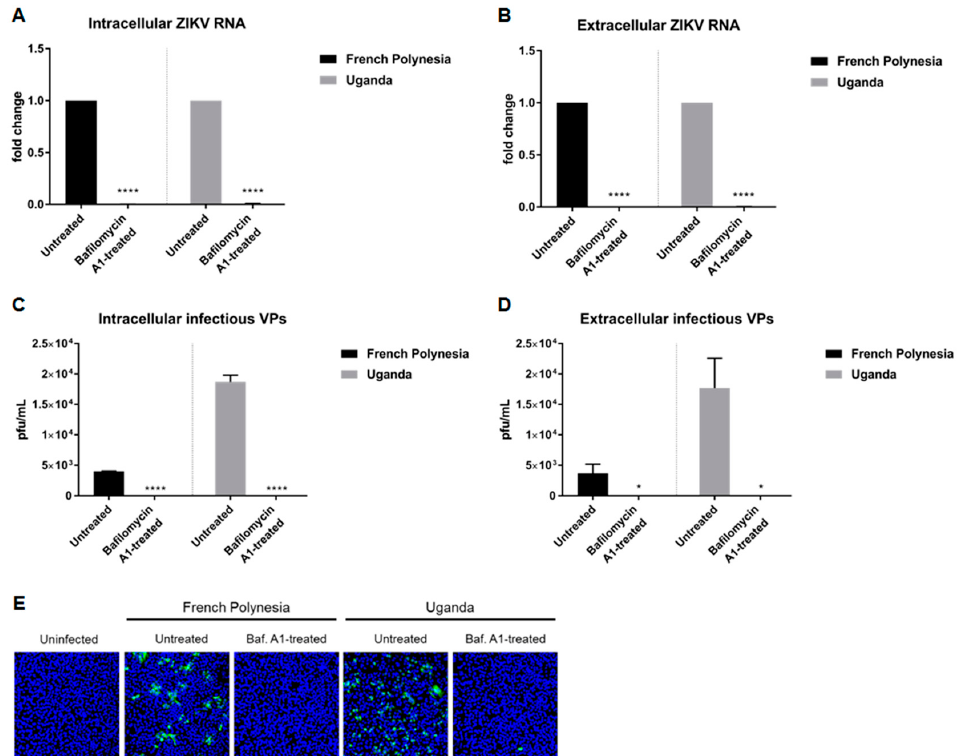
Figure 1. Bafilomycin A1 prevents the establishment of ZIKV infection in A549 cells ( A ) Quantification of the amount of intracellular ZIKV RNA of A549 cells infected with either the French Polynesia or the Uganda strain and treated with 10 nM bafilomycin A1 (pre-infection treatment). Quantification was performed by RT-qPCR and the amount of ZIKV RNA was normalized to the amount of the RPL27 transcripts. Infected untreated cells were used as control; ( B ) Quantification of the amount of extracellular ZIKV RNA of A549 cells infected with either the French Polynesia or the Uganda strain and treated with 10 nM bafilomycin A1 (pre-infection treatment). Quantification was performed by RT-qPCR and infected untreated cells served as control; ( C ) Quantification of the number of intracellular infectious viral particles (VPs) from A549 cells infected with either the French Polynesia or the Uganda strain and treated with 10 nM bafilomycin A1 (pre-infection treatment). Quantification was performed in Vero cells by plaque assay and the number of infectious viral particles is expressed in plaques forming units per mL (pfu/mL). Infected untreated cells were used as control; ( D ) Quantification of the number of extracellular infectious viral particles (VPs) from A549 cells infected with either the French Polynesia or the Uganda strain and treated with 10 nM bafilomycin A1 (pre-infection treatment). Quantification was performed in Vero cells by plaque assay and the number of infectious viral particles is expressed in plaques forming units per mL (pfu/mL). Infected untreated cells served as control; ( E ) A549 cells were infected with either the French Polynesia or the Uganda strain and treated with 10 nM bafilomycin A1 (pre-infection treatment). Cells were fixed with ethanol:acetone (1:1) and nuclei were visualized with DAPI (blue) and the ZIKV envelope protein with a specific antibody (green). Pictures were taken with the 16× objective. * p ≤ 0.05; **** p ≤ 0.0001.